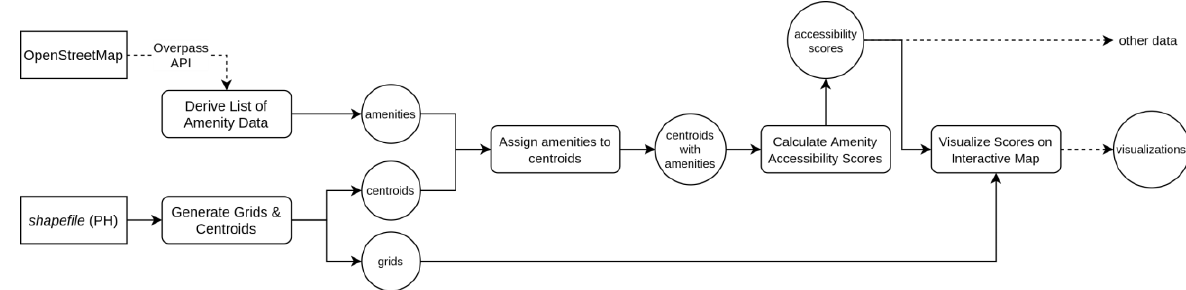
Figure 1 : Methodological Framework for Measuring Geospatial Amenity